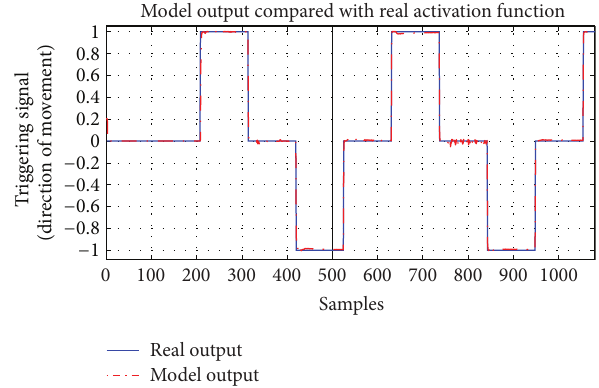
Figure 7: Modelling of the activation function of the orthosis. The precision of the model can be seen in this enlargement.